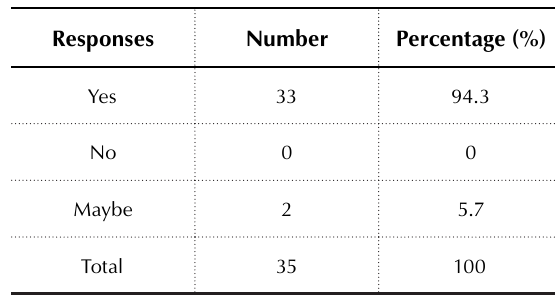
Table 2. Is there any possibility of the usage of e-banking as a marketing tool?